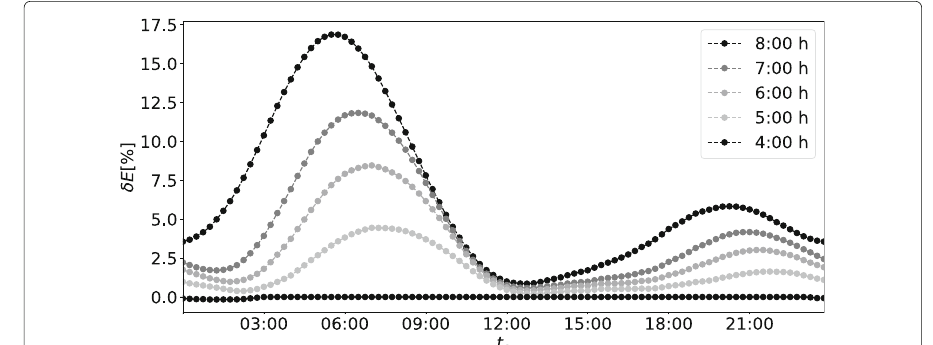
Fig. 2 Relative CO 2 reduction δ E for different temporal flexibility h and starting times t